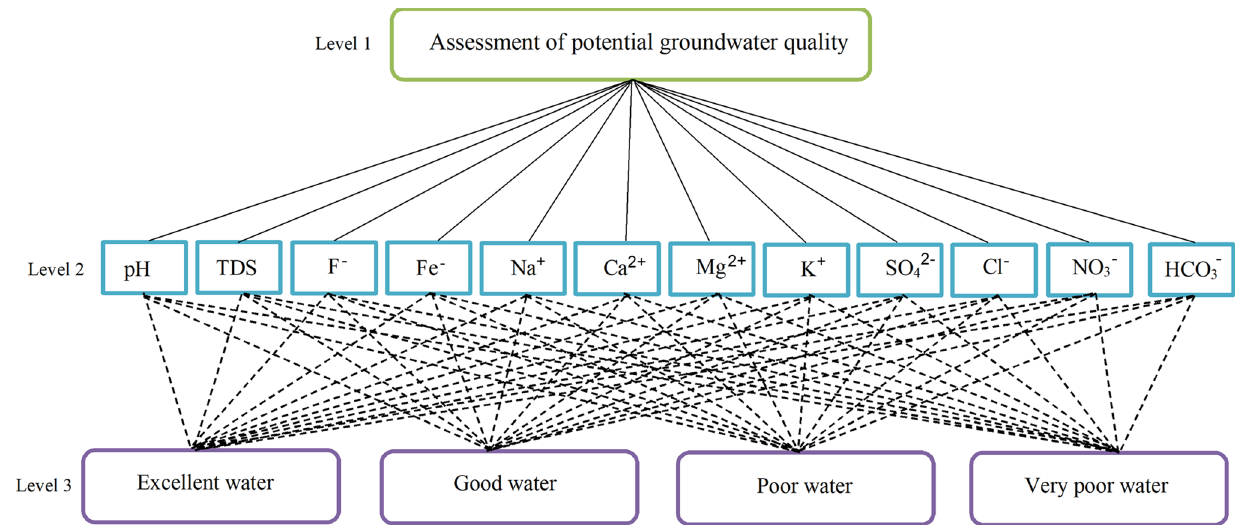
Fig. 3 The hierarchy structure for the performance evaluation process of groundwater quality assessment